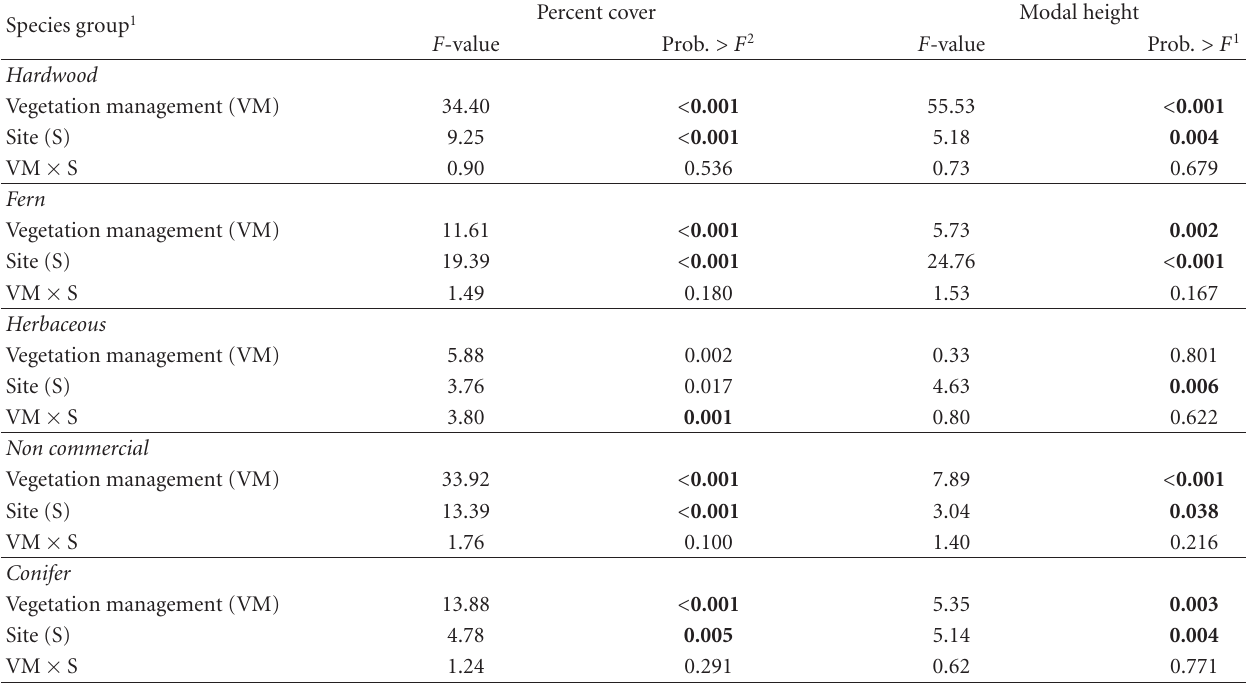
Table 2: ANOVA results for competing vegetation